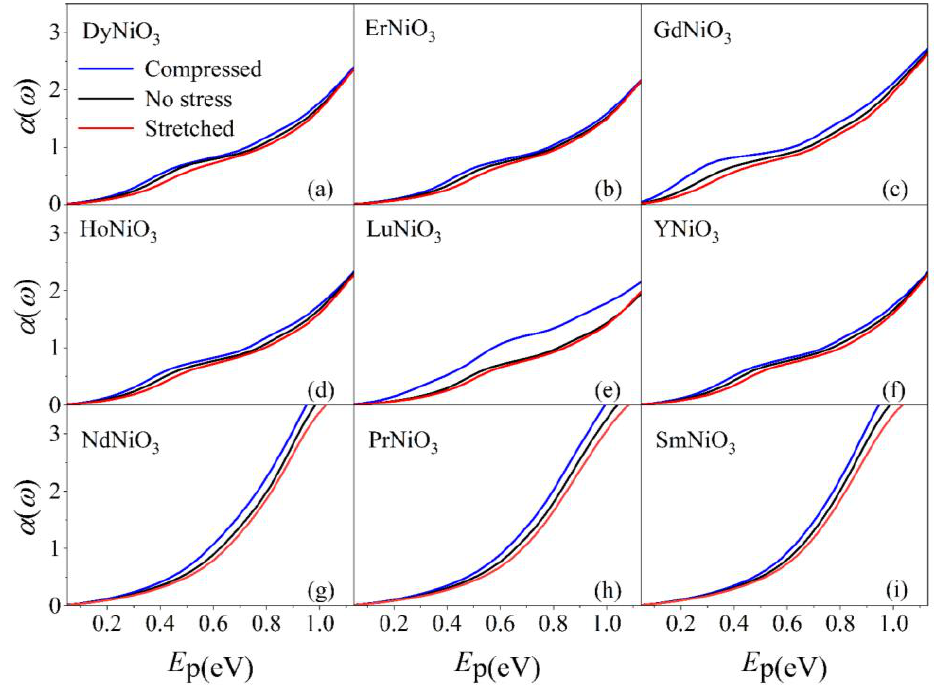
Figure 3. Absorption coefficients of DyNiO 3 ( a ), ErNiO 3 ( b ), GdNiO 3 ( c ), HoNiO 3 ( d ), LuNiO 3 ( e ), YNiO 3 ( f ), NdNiO 3 ( g ), PrNiO 3 ( h ), and SmNiO 3 ( i ), where the absorption coefficient is given in 10 5 cm −1 .